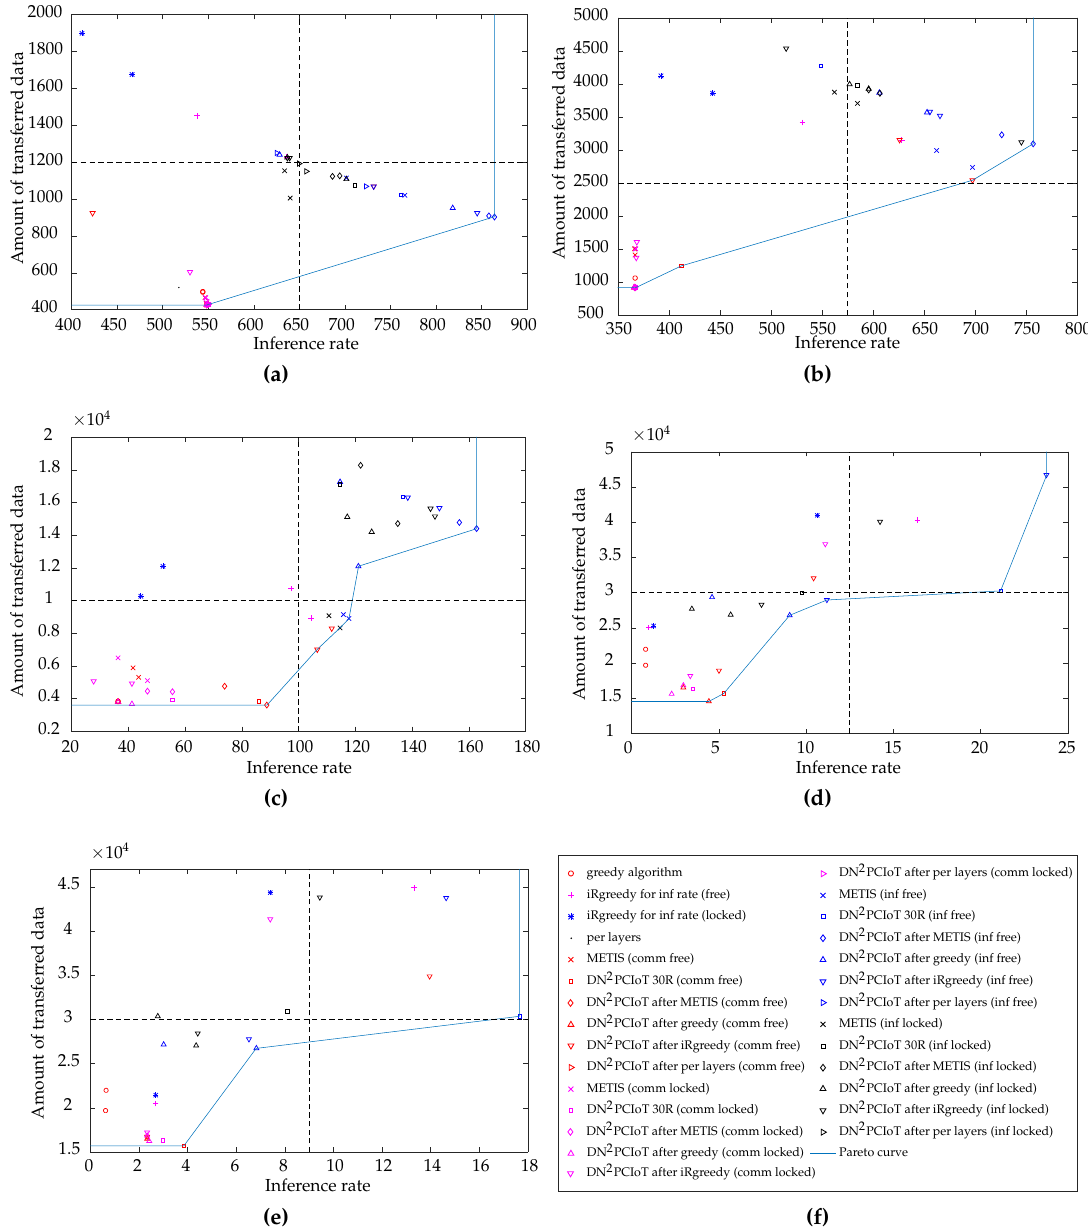
Figure 7. Inference rate and communication values for: ( a ) 2-device experiments; ( b ) 4-device experiments; ( c ) 11-device experiments; ( d ) 56-device experiments; and ( e ) 63-device experiments; and ( f ) legend for all